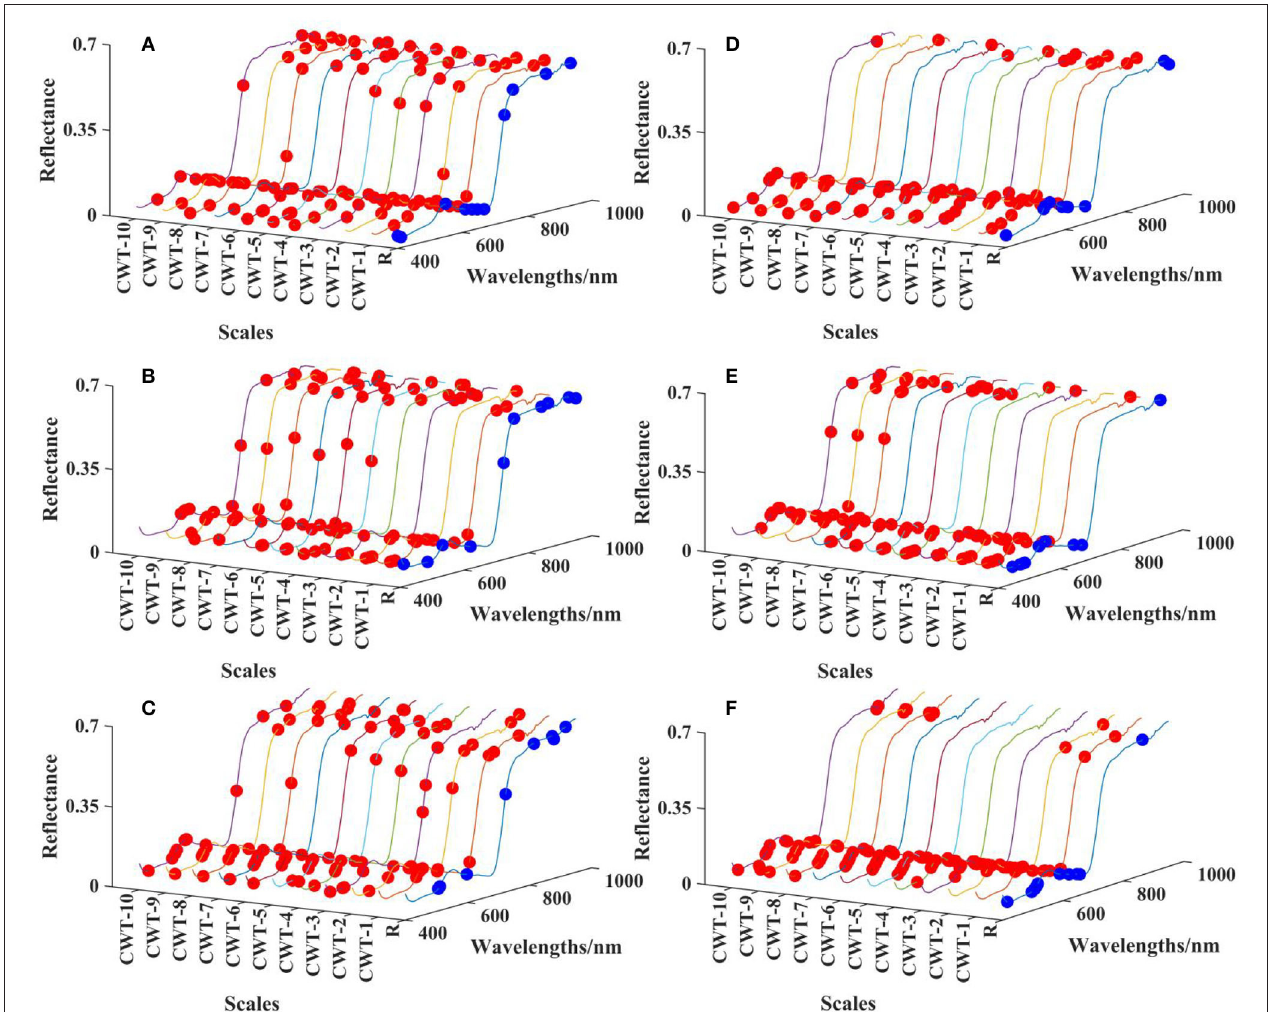
FIGURE 6 | Characteristic wavelengths of the R spectrum and CWT spectra screened by CARS and RF algorithms. The red and blue dots represent the characteristic wavelengths of CWT spectra and R spectrum, respectively. (A) Budding stage, CARS. (B) Flowering stage, CARS. (C) Boll setting stage, CARS. (D) Budding stage, RF. (E) Flowering stage, RF. (F) Boll setting stage,